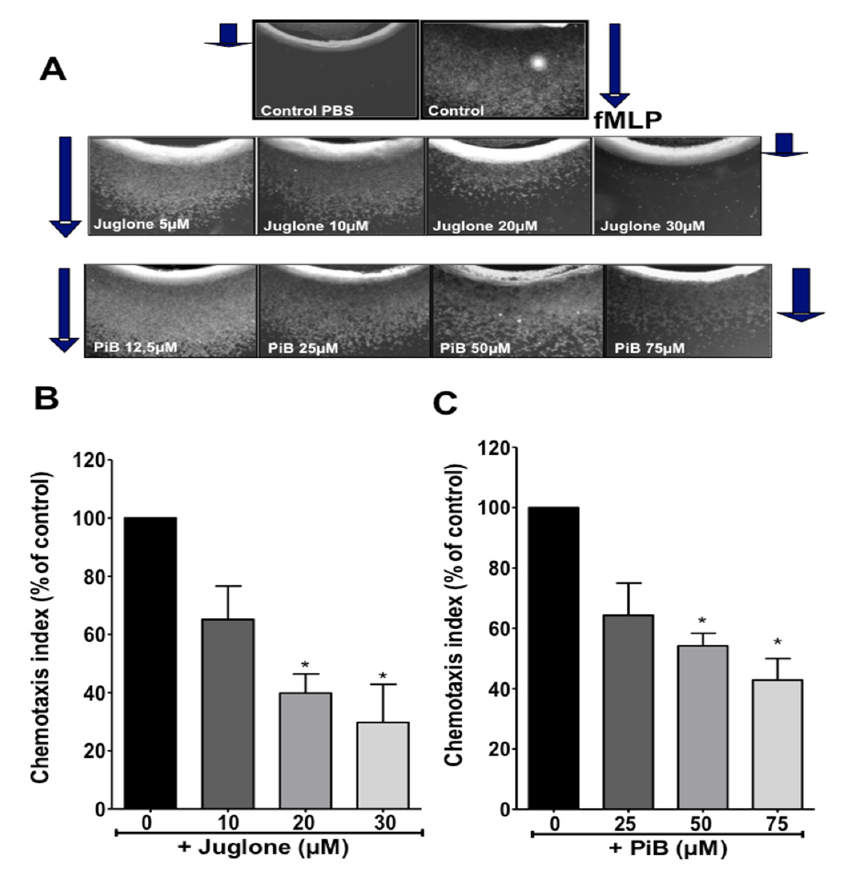
Figure 3. Effect of juglone and PiB on neutrophil chemotaxis. ( A ) Neutrophils (100 × 10 6 cell/mL) were pretreated with increasing concentration of juglone (0, 10, 20, 30 µ M) or PiB (0, 25, 50, 75 µ M). Cells (5 µ L) are added to the agarose central well, 5 µ L of the chemoattractant fMLP (10 − 7 M) or buffer PBS are placed in the other wells, the plates are incubated for 2 h at 37 ◦ C. Results were observed using a ZEISS microscope. The direction of migration towards fMLP is shown by the arrows. ( B , C ) The chemotaxis index is determined as the distance of cell migration to fMLP. Results are represented as the ratio to fMLP without inhibitors (100%). Histograms represent the percentage of inhibition of cell migration, in the presence of Pin1 inhibitors. Data are means ± S.E.M. of 4 separate experiments (* p <